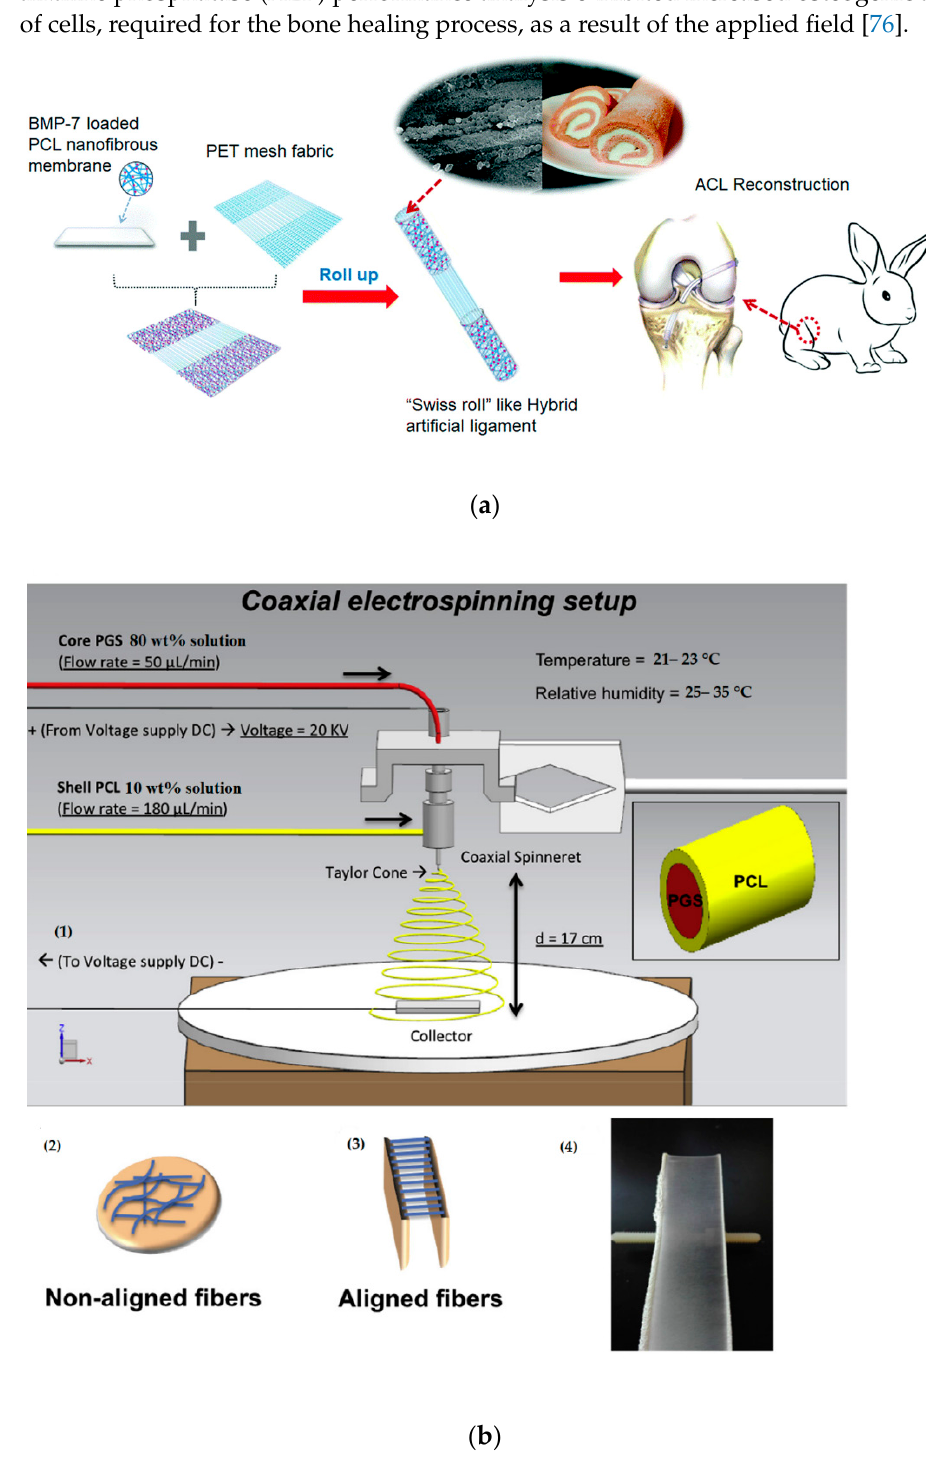
Figure 3. Schematic diagram of fabrication of ( a ) novel hybrid artificial ligament used for reaching the “ligamentization” after ACL reconstruction (reproduced from [74] with permission of Royal Society of Chemistry, 2019). ( b ) coaxial aligned PGS/PCL nanofibers (1). Non-aligned nanofibers were produced in a round copper collector plate (2), and aligned nanofibers were recovered in a two parallel copper plate collector (3, 4) (reproduced from [75] with permission of Elsevier, 2019).